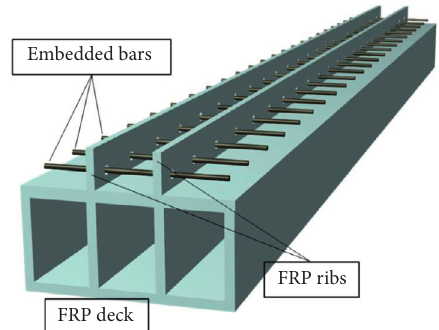
Figure 21: FRP perforated connectors for hybrid decks.